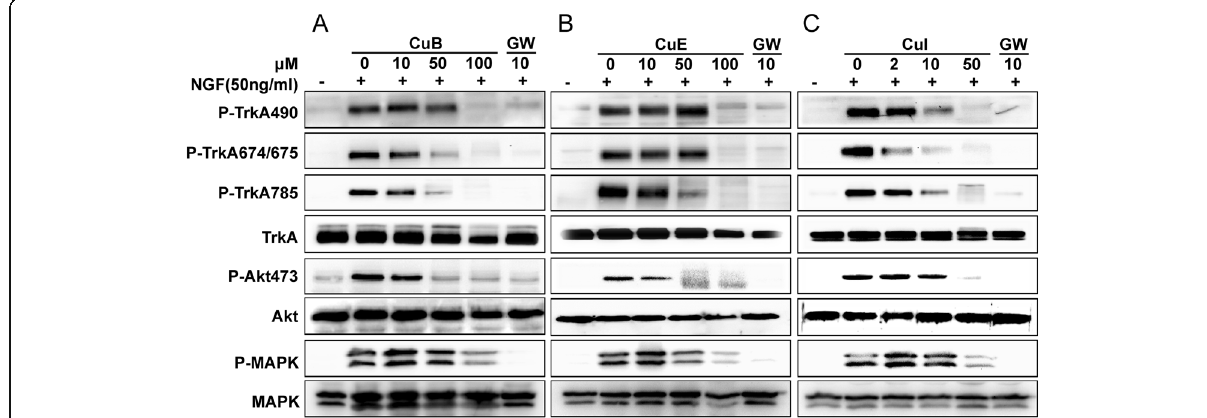
Fig. 3 Cucurbitacins inhibit nerve growth factor (NGF)-mediated tropomyosin receptor kinase A (TrkA) pathway in PC12 cells. The inhibition of TrkA phosphorylation induced by cucurbitacin B (CuB), CuE, and CuI was assayed in the presence or absence of the indicated cucurbitacin concentrations, and the inhibitor GW441756 as a positive control. ( a ) CuB inhibited TrkA and downstream Akt phosphorylation in a concentration-dependent manner. ( b ) CuE inhibited TrkA and downstream Akt phosphorylation in a concentration-dependent manner. ( c ) CuI inhibited TrkA and downstream Akt phosphorylation in a concentration-dependent manner. The blot shown is representative of at